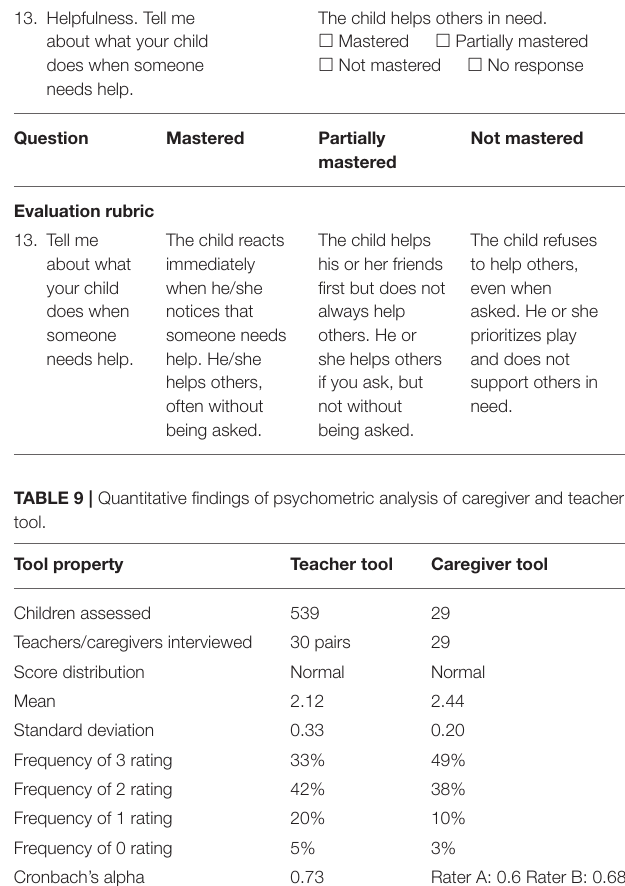
TABLE 8 | Example revised questionnaire item. Questionnaire item